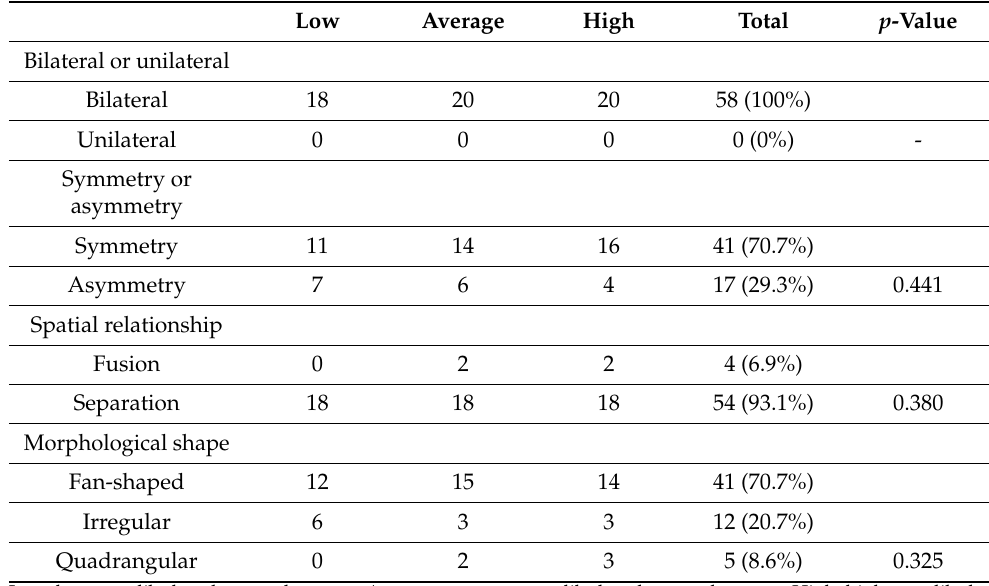
Table 1. Morphological characteristics of the frontal